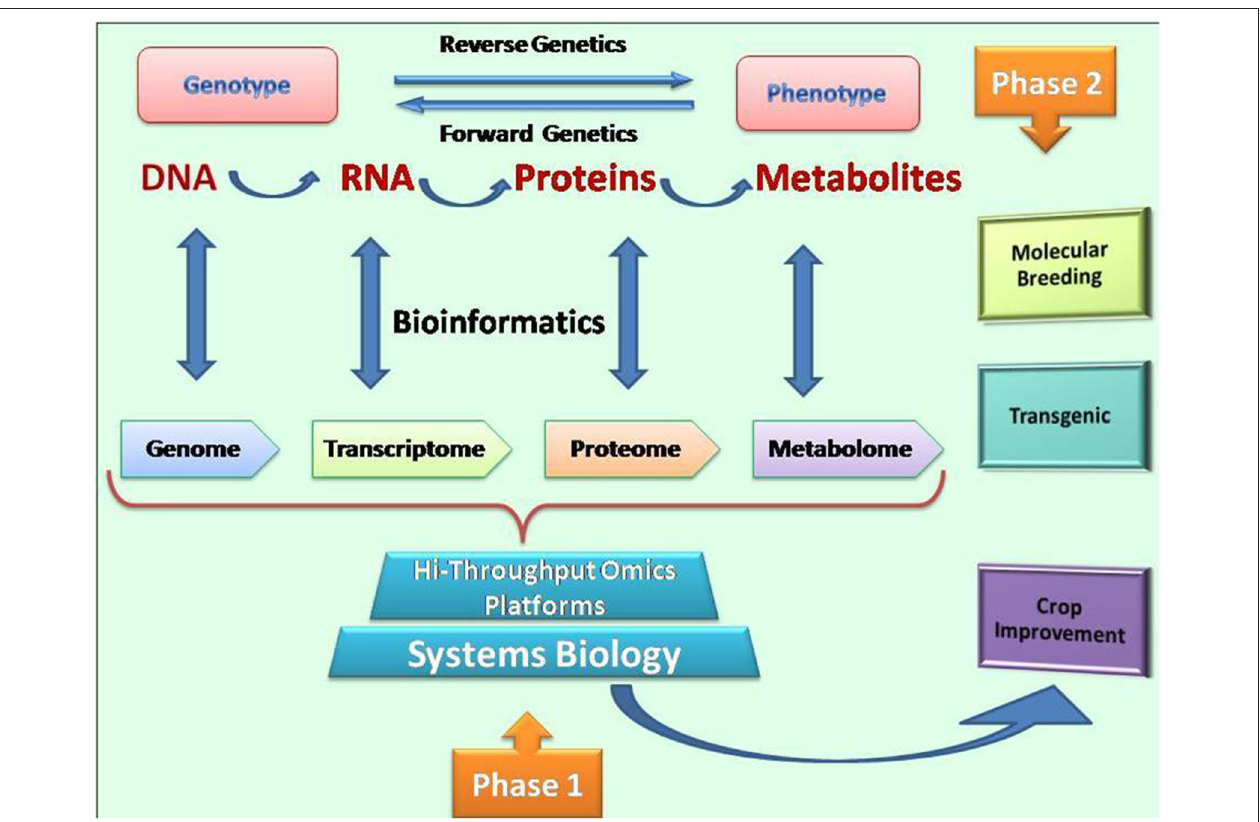
FIGURE 2 | Omics approaches for crop improvement: filling the gaps between genotype and phenotype in order to resolve agriculturally important complex traits.